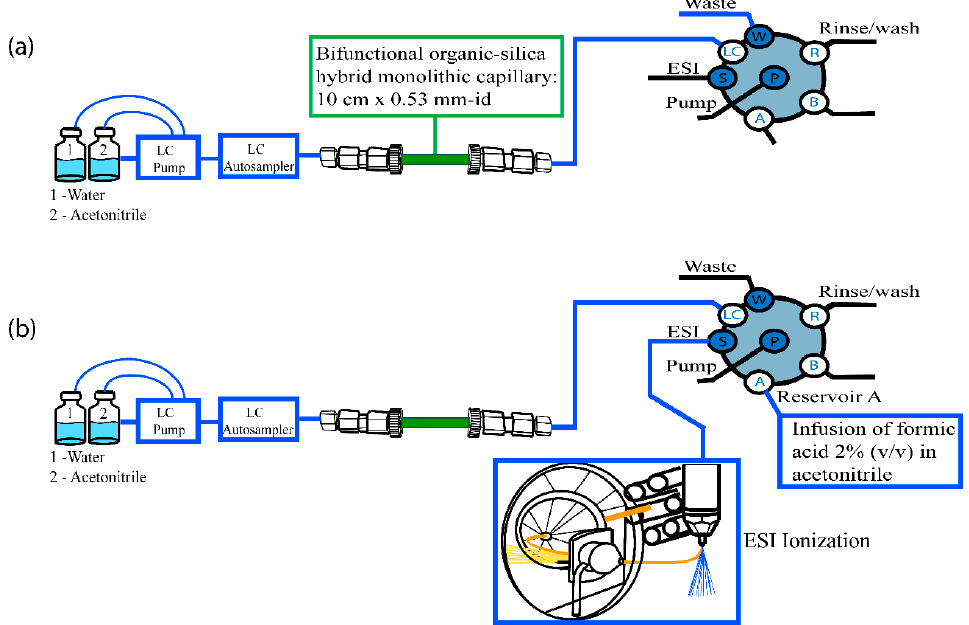
Figure 7. Scheme of in-tube SPME-MS/MS procedure). In the first step ( a ) (MS/MS valve in position 1), diluted sample (10 μ L) was percolated through the monolithic capillary to pre-concentrate the analytes. After, ( b ) the valve was switched to position 2 for elution of the analytes From 4 to 7 min, acetonitrile with 2% ( v / v ) of formic acid was post-capillary infused.